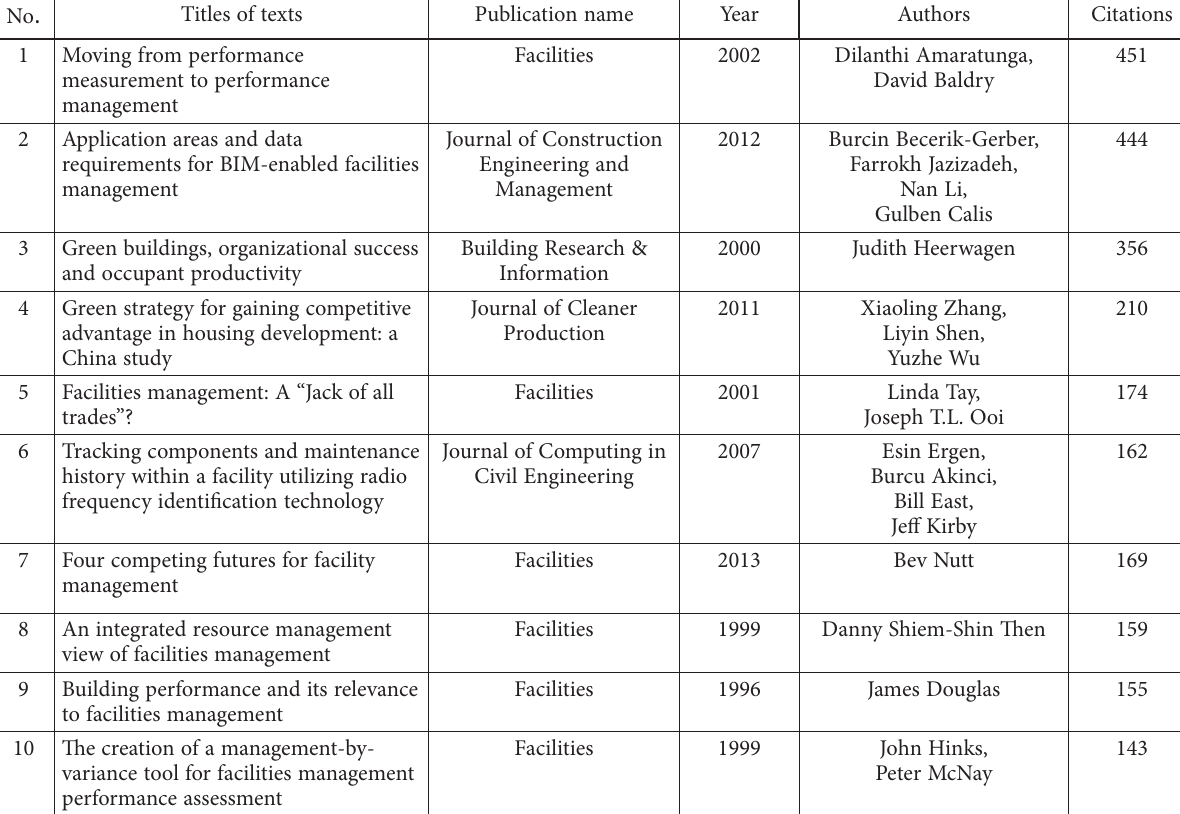
Table 2. Top-10 publications with the most